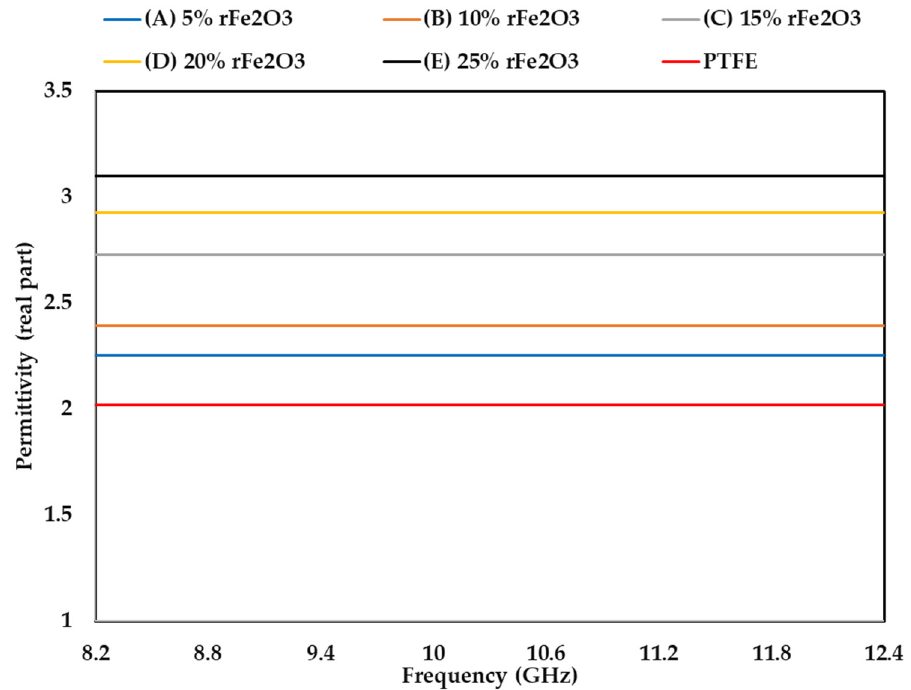
Figure 11. Variation in permittivity (real part) of rFe 2 O 3 –PTFE nanocomposites using rectangular waveguide.